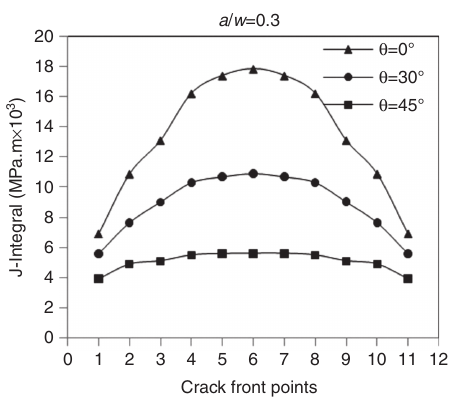
Figure 20 Effect of crack angle on J-integral.